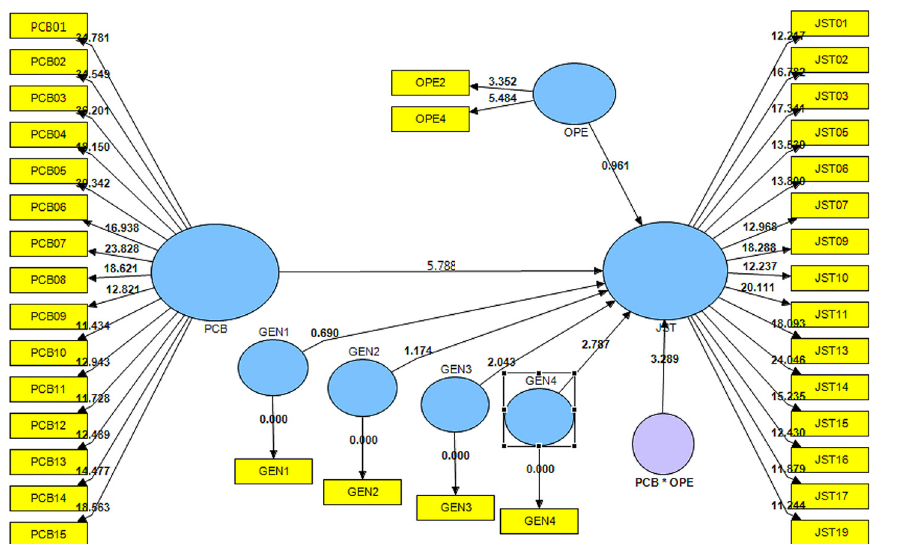
Figure 5. T -statistics of